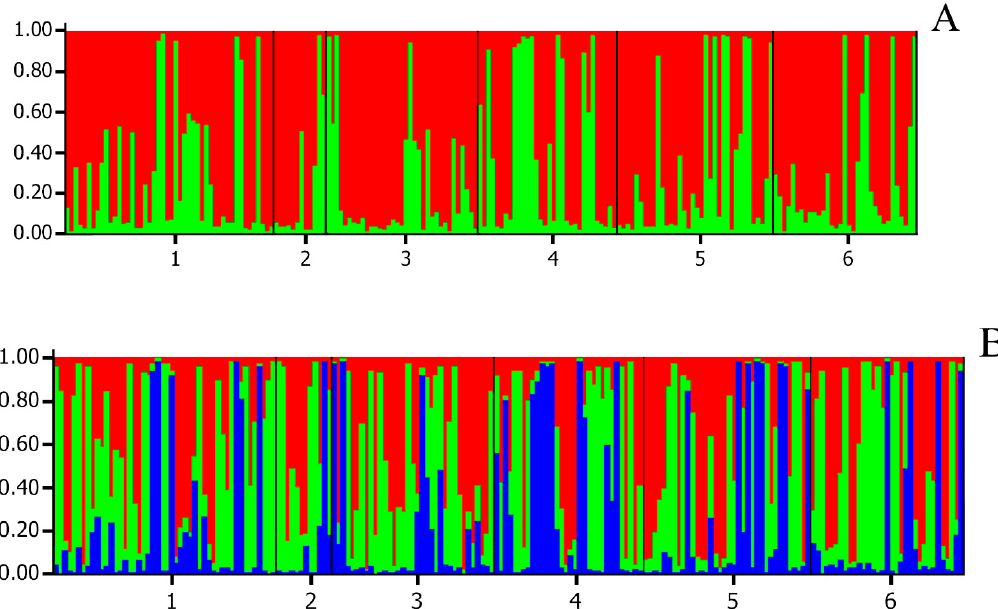
Figure 3. Structure analysis for K = 2 ( A ) and K = 3 ( B ) of six Polish Konik paternal lineages based on the ∆ K method. 1, Wicek; 2, Myszak; 3, Glejt I; 4, Goraj; 5, Chochlik; 6, Liliput.